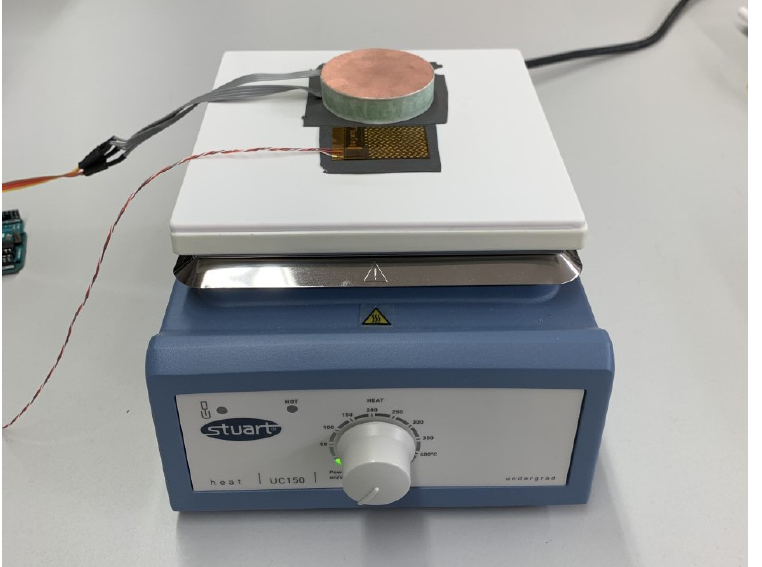
Figure 9. Calibration setup: UC150 heater, Fluxteq PHFS-01 sensor, and 3D-printed HF